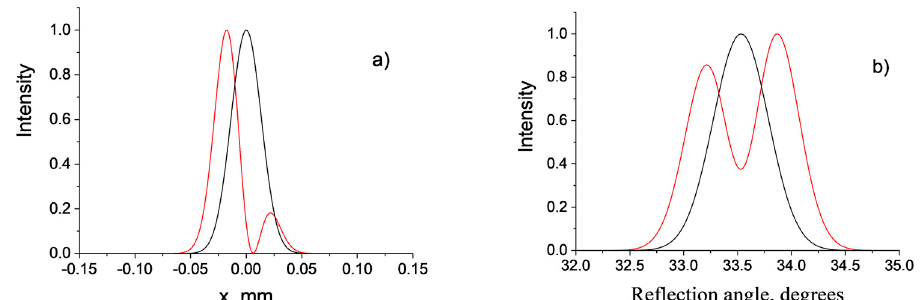
Figure 5. Normalized intensity profiles as function of the transverse coordinate ( a ) and reflection angle ( b ). Black lines—incident beam; red lines—reflected beams. Incident beam FWHM = 26.64 μ m; θ i = 33.53 ◦ ; z = 0.